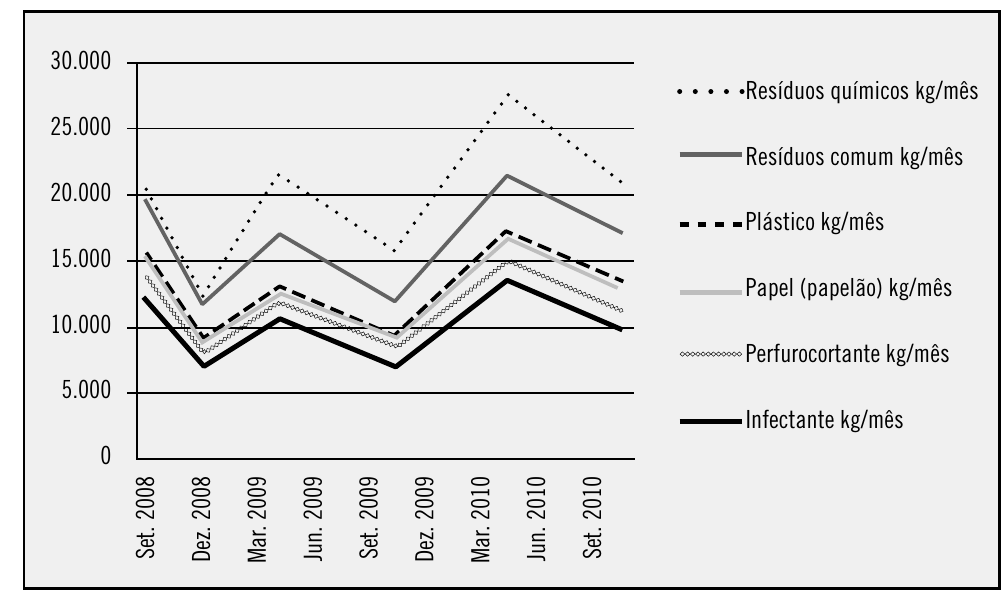
Figura – Amostragem de tipo de resíduo gerado pelo laboratório. 2008, 2009, 2010. São Paulo-SP, Brasil